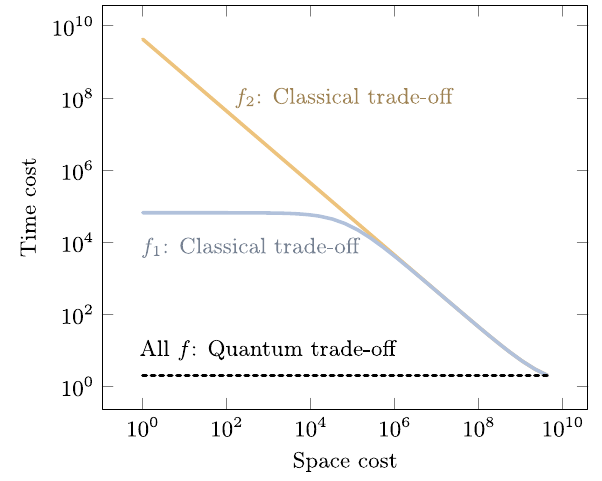
FIG. 5. Classical versus quantum space-time trade-off. The optimal trade-off between space cost and time cost of implementing stochastic matrices for a system of s ¼ 32 bits, i.e., with dimension d ¼ 2 32 (plotted in log-log scale). Solid colored curves correspond to optimal trade-offs for classically implementing exemplary f 0 ; 1 g -valued stochastic matrices de- scribed by functions f 1 ð i Þ ¼ i ⊕ 1 (addition modulo d ) and f 2 ð i Þ ¼ min f i þ 2 s= 2 ; 2 s − 1 g , as analyzed in Ref. [10]. The dashed black curve corresponds to optimal trade-offs for quan- tumly implementing any f 0 ; 1 g -valued stochastic matrix, thus illustrating a quantum